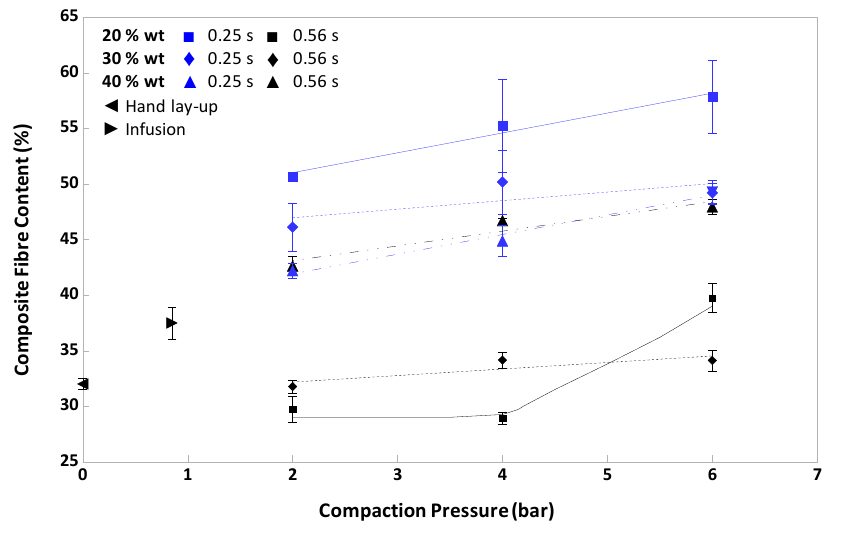
Figure 13. Fibre content of the composites with prepreg fibre contents of 20 ( ■ ), 30 ( ♦ ), and 40 wt.% ( ▲ ) and an exposure time of 0,56 s, and that of the composites with prepreg fibre contents of 20 ( ■ ), 30 ( ♦ ), and 40 wt.% ( ▲ ) and an exposure time of 0.25 s vs. the compaction pressure.